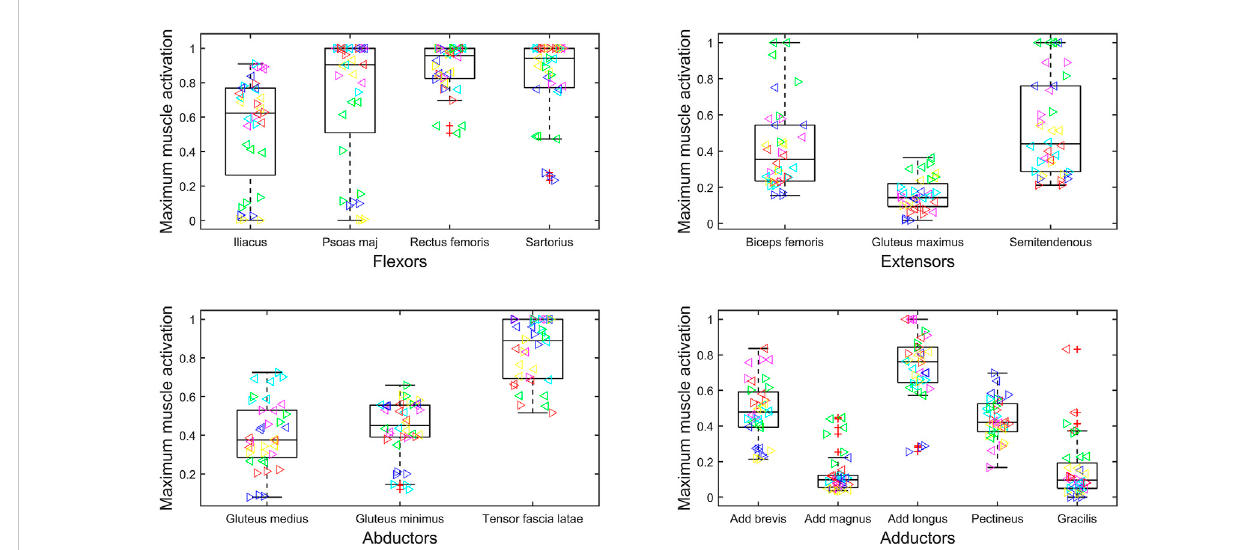
FIGURE 2 Maximum muscleactivation (forcenormalizedto F i max ) during gaitcycleofbilateraltransfemoralpersonswithlimbloss.Musclesarecategorizedas hip fl exors,extensors,abductors,andadductors.Theboxplotsshowmin,max,median,25and75percentiles,andtheoutliers.Eachsubjectisplottedina separate color, and the left legs are represented by ‘ ► ’ and right by ‘ ► ’ .